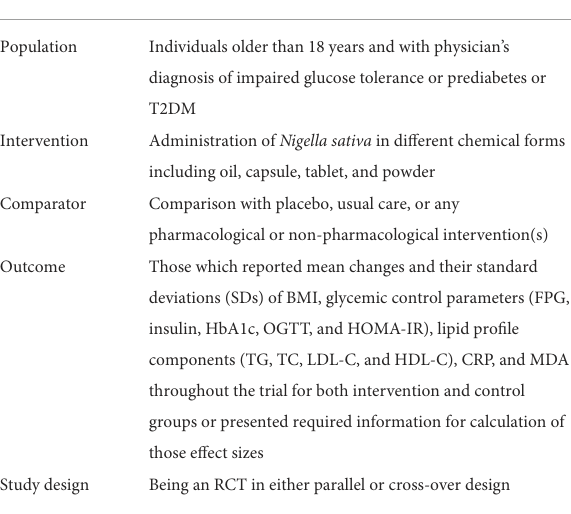
TABLE 1 Population, intervention, comparison, outcomes, and study design (PICOS) criteria for inclusion of studies.